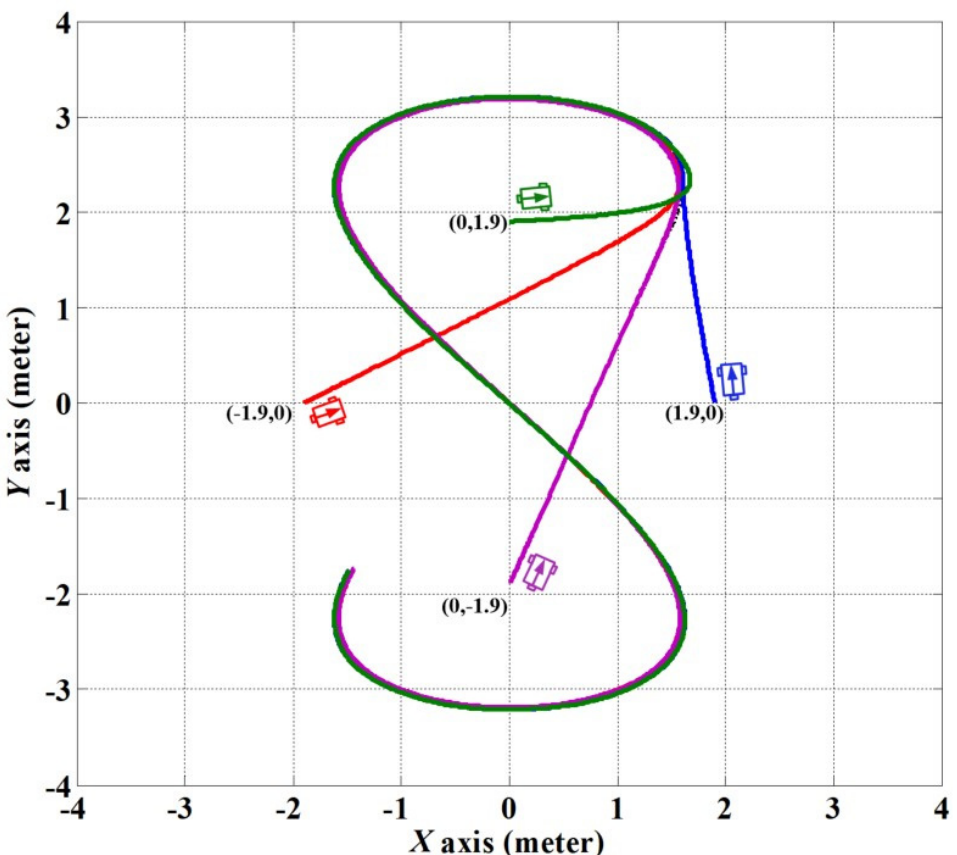
Figure 11. S type trajectory tracking result of H 2 - proposed control design with respect to four different initial conditions: ( x c = 1.9 m, y c = 0 m, blue line), ( x c = − 1.9 m, y c = 0 m, red line), ( x c = 0 m, y c = 1.9 m, green line), and ( x c = 0 m, y c = − 1.9 m, purple line).